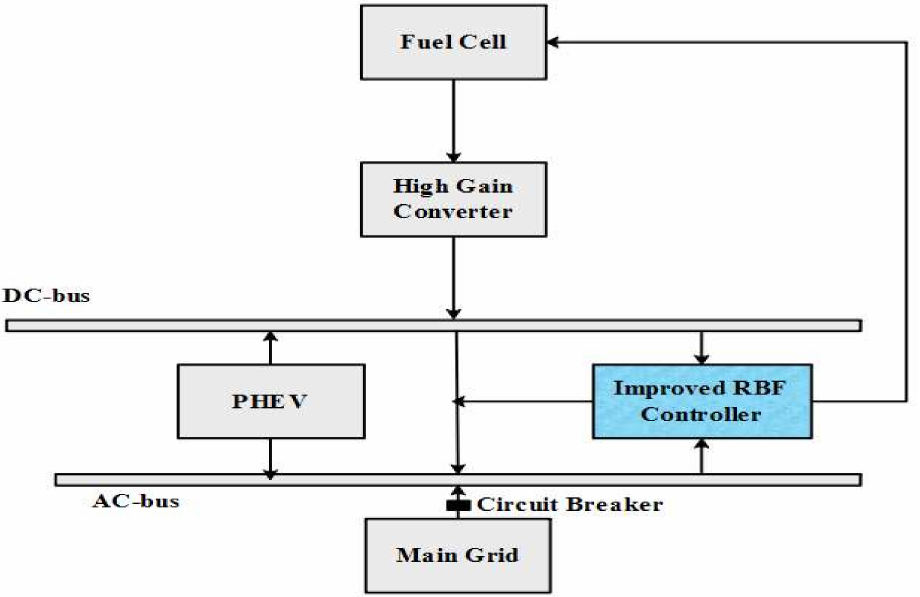
Figure 1. Block diagram for the FC-integrated high-gain converter.